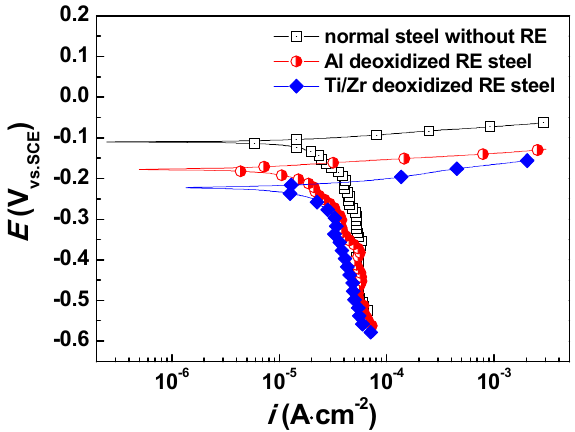
Figure 1. Potentiodynamic polarization curves of steels in a 3.5 wt.% NaCl solution.